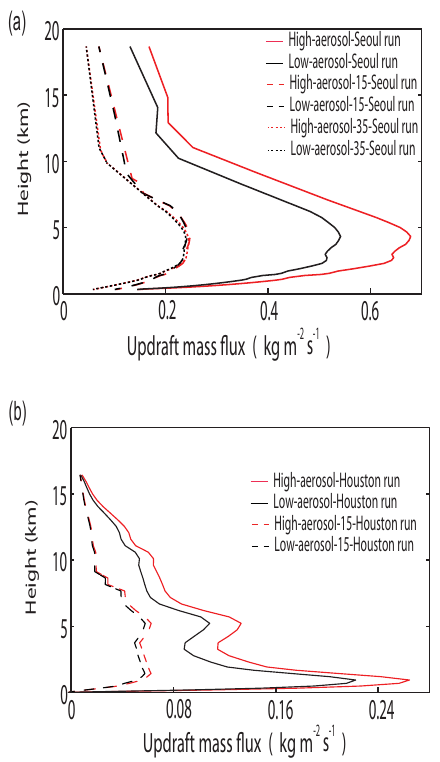
Figure 7. Vertical distributions of the time- and domain-averaged updraft mass fluxes for (a) the Seoul case and (b) the Houston case. Solid lines represent simulations at the 500m resolution, while dashed lines represent those at the 15km resolution. Dotted lines represent simulations at the 35km resolution.